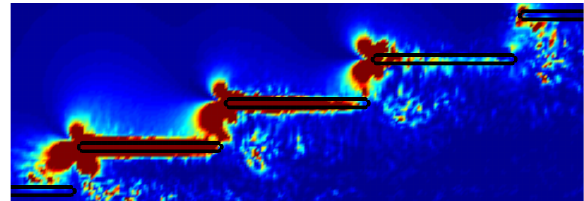
Fig. 11. Computed power spectral density of pressure